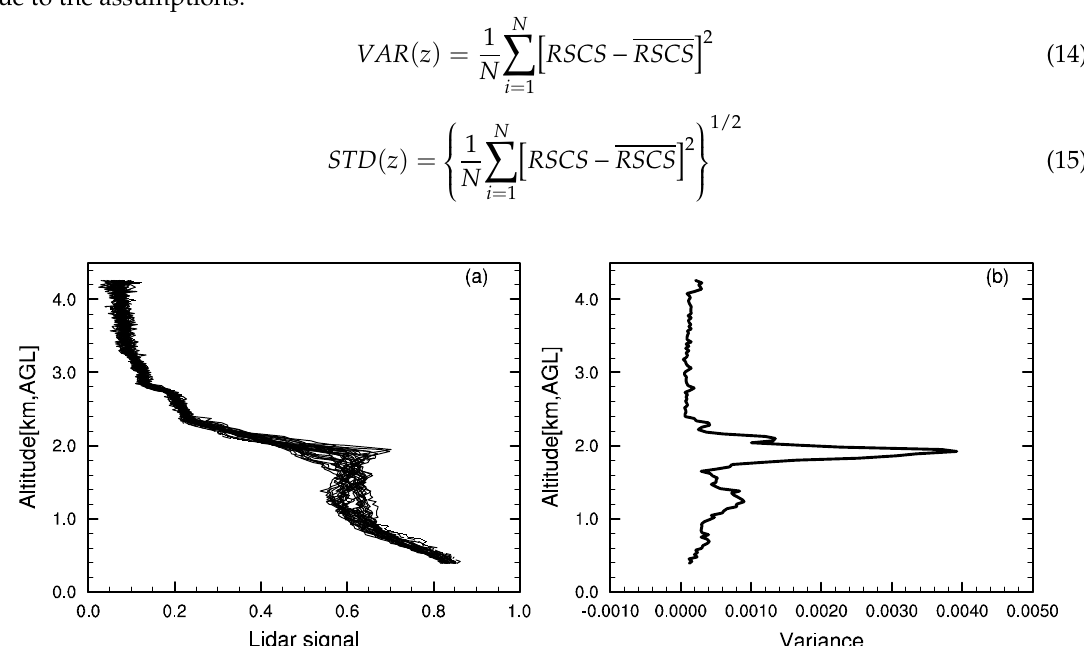
Figure 7. ( a ) 31 vertical RSCS profiles between 05:15-05:45 UTC (1 min interval) on 10 September 2010 over SACOL, ( b ) vertical profile of temporal variance (VAR).